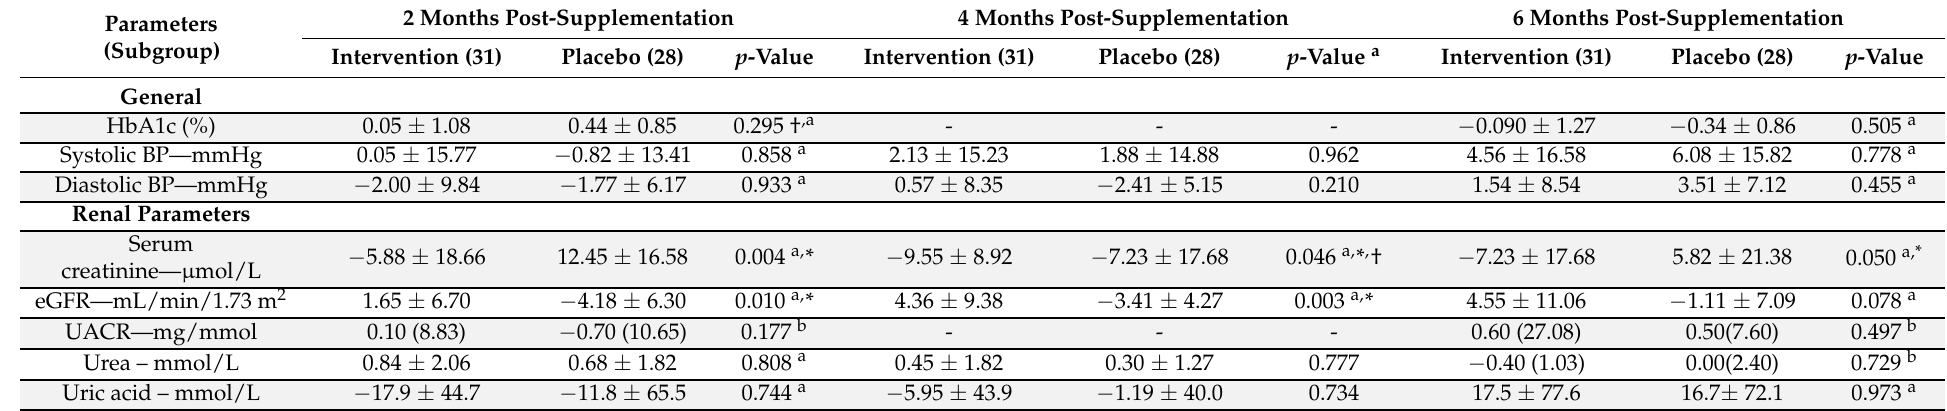
Table 5. Subgroup analysis comparing tocotrienol-rich vitamin E supplementation between intervention and placebo group at 6 months.